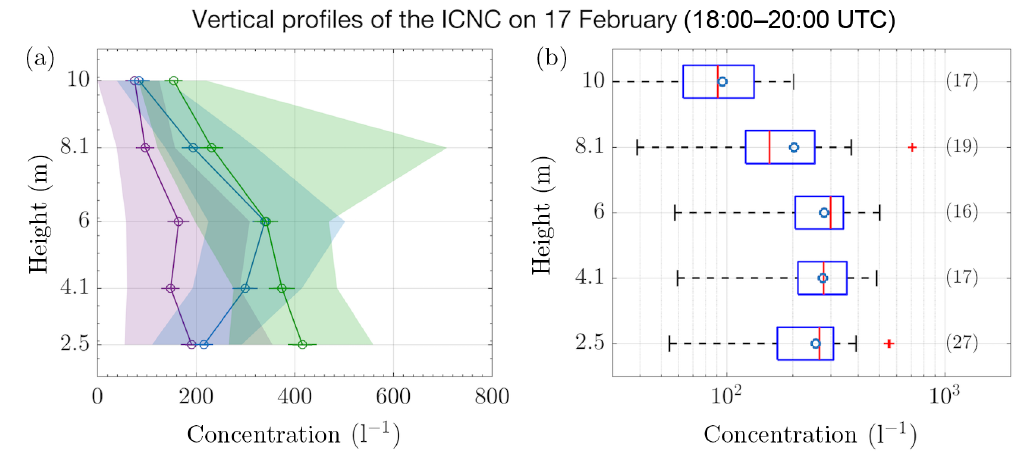
Figure 10. As Fig. 7, but for ICNC as a function of height observed on 17 February 2017.